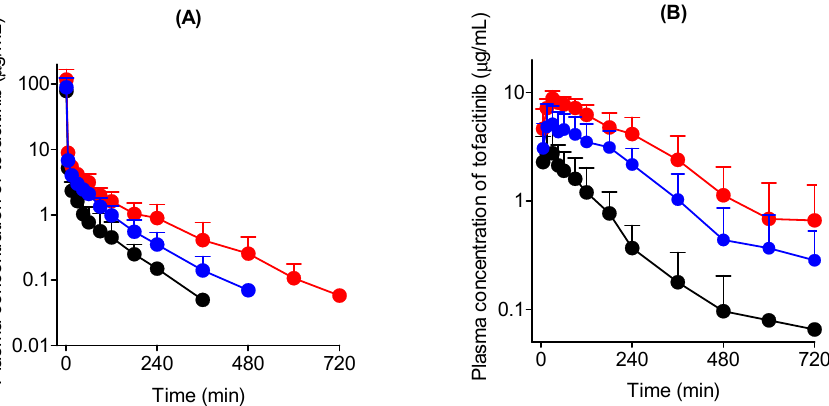
Figure 3. ( A ) Mean arterial plasma concentration–time curves of tofacitinib after 1 min intravenous infusion at a dose of 10 mg/kg to CON (black; n = 5), LC (red; n = 6) and LC-ISN (blue; n = 7) rats. ( B ) Mean arterial plasma concentration–time curves of tofacitinib after oral administration at a dose of 20 mg/kg to CON ( n = 6), LC ( n = 7) and LC-ISN ( n = 7) rats. Bars represent standard deviations. CON, control; LC, liver cirrhosis induced by N -dimethylnitrosamine; LC-ISN, LC with treatment of